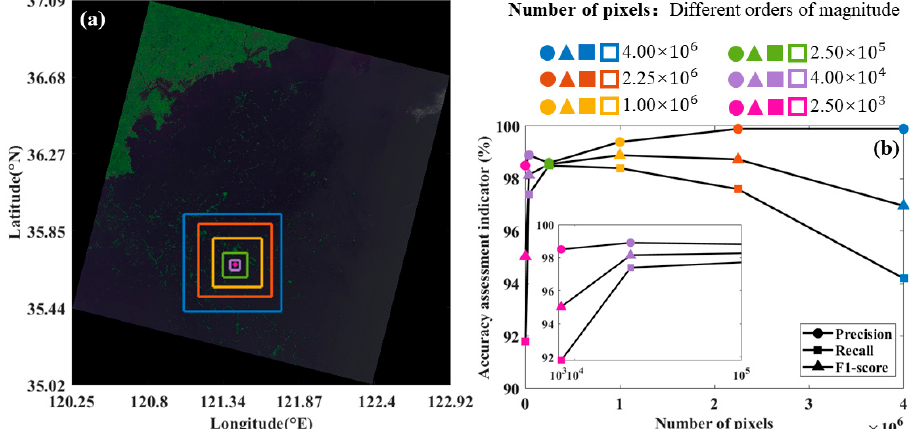
Figure 9. Accuracy assessment of extraction results with different orders of magnitude of pixel numbers (RS data: Landsat 8, 23 June 2021, Worldwide Reference System: path 119 and row 35). ( a ) is a schematic diagram of extraction regions of different orders of magnitude pixel numbers and ( b ) is